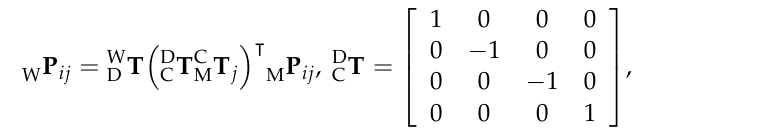
Figure 10. Scheme of marker pose recovery in camera coordinate system using camera geometry.